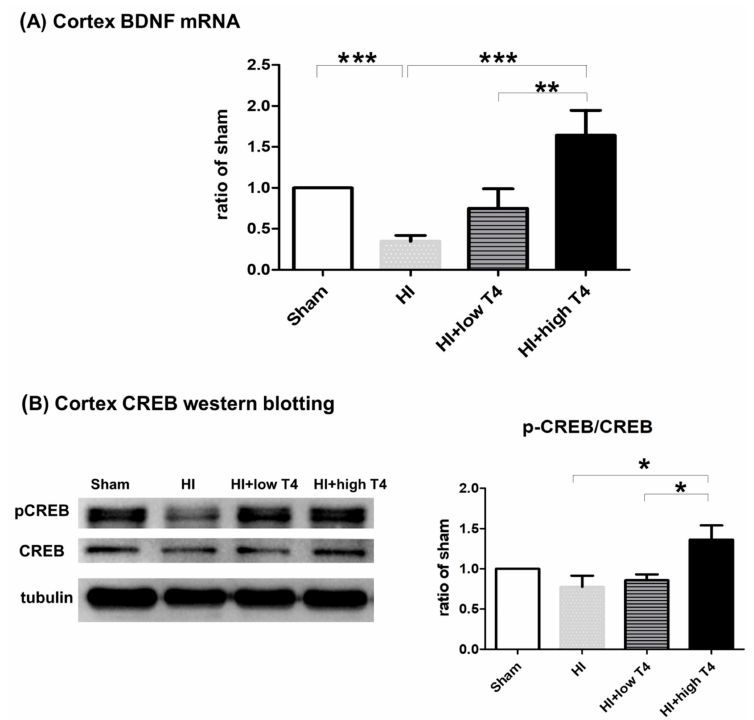
Figure 7. T4 treatment increased BDNF expression in cortical neurons. ( A ) HI significantly decreased BDNF mRNA expression in the cortex, whereas a high dose of T4 attenuated HI-induced loss of BDNF expression. ( B ) Concentrations of phosphorylated CREB were significantly increased in the cortex with a high dose of T4 treatment. * p < 0.05; ** p < 0.01; *** p <